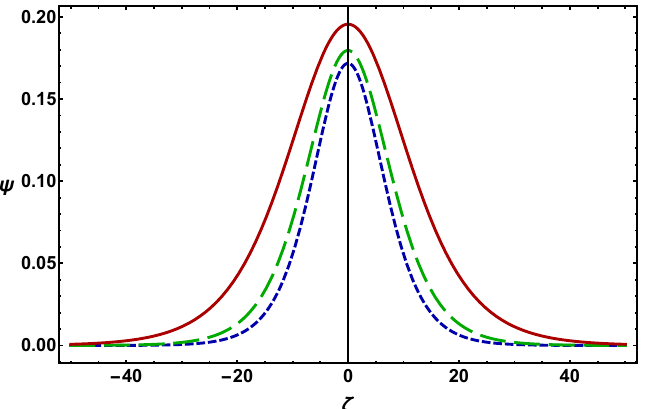
Figure 4. The effect of temperature on NA wave potential ψ in degenerate ultra-relativistic plasmas by considering σ Te = 0 (blue dotted curve), σ Te = 0.1 (green dashed curve), and σ Te = 0.2 (red solid curve) when θ = 5 ◦ , Ω c = 0.05, Ω 0 = 0.03, l x = 0.2, σ e = 0.1, and δ = 0.3.